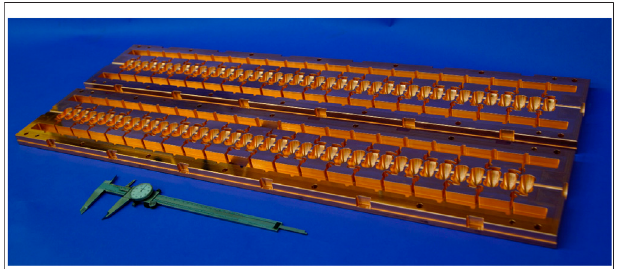
FIGURE5| BothhalvesoftheC 3 prototypestructure priortobraze.The 1 m structure consists of 40 cavities. A rf manifold that runs parallel to the structurefeeds 20cavitiesoneach side. Thestructure operatesat 5.712 GHz - from